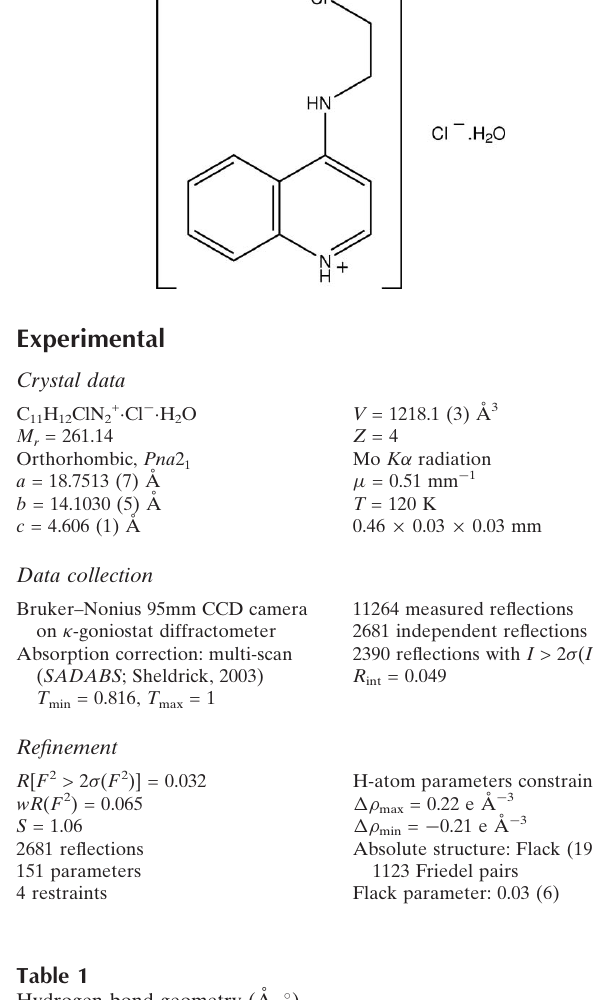
Hydrogen-bond geometry (A˚ , (cid:4)